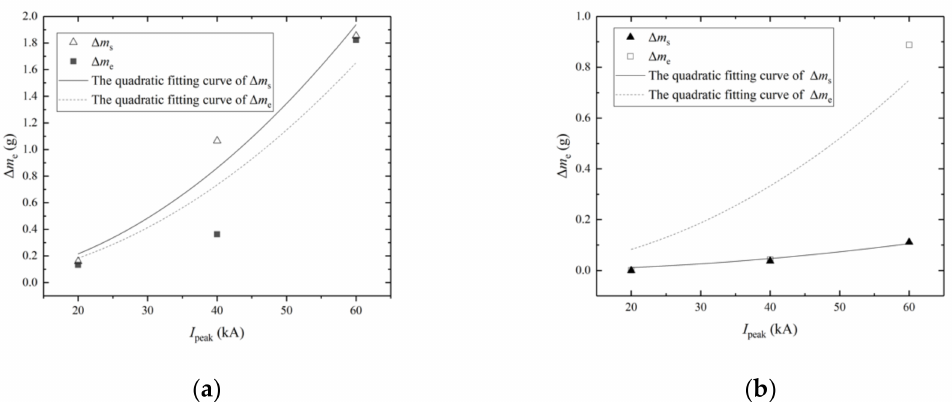
Figure 17. The quadratic curve fitting between ablation mass losses and peak currents in the experiments and FEA: ( a ) the result of Group A; ( b ) the result of Group B. ∆ m s and ∆ m e are ablation mass losses in FEA and the experiments,